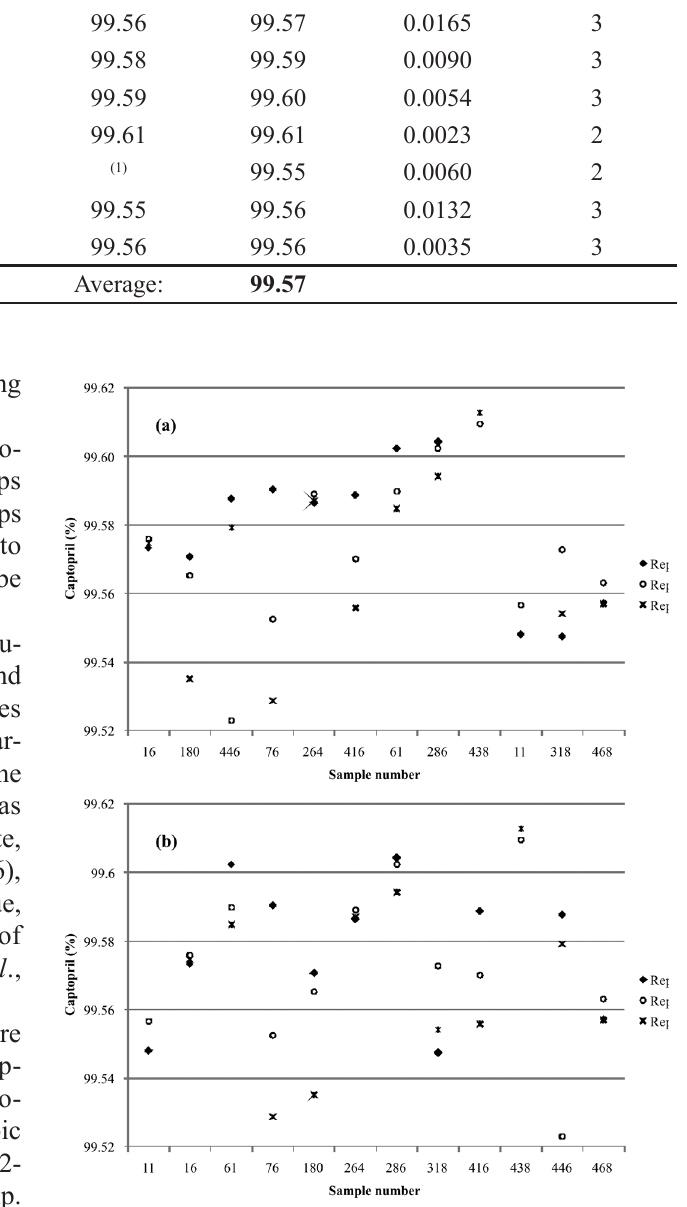
FIGURE 3 - Results for the homogeneity study: captopril contents in twelve samples analyzed in triplicate and ordered from left to the right according to: (a) the HPLC injection order; and (b) the packaging order (serial